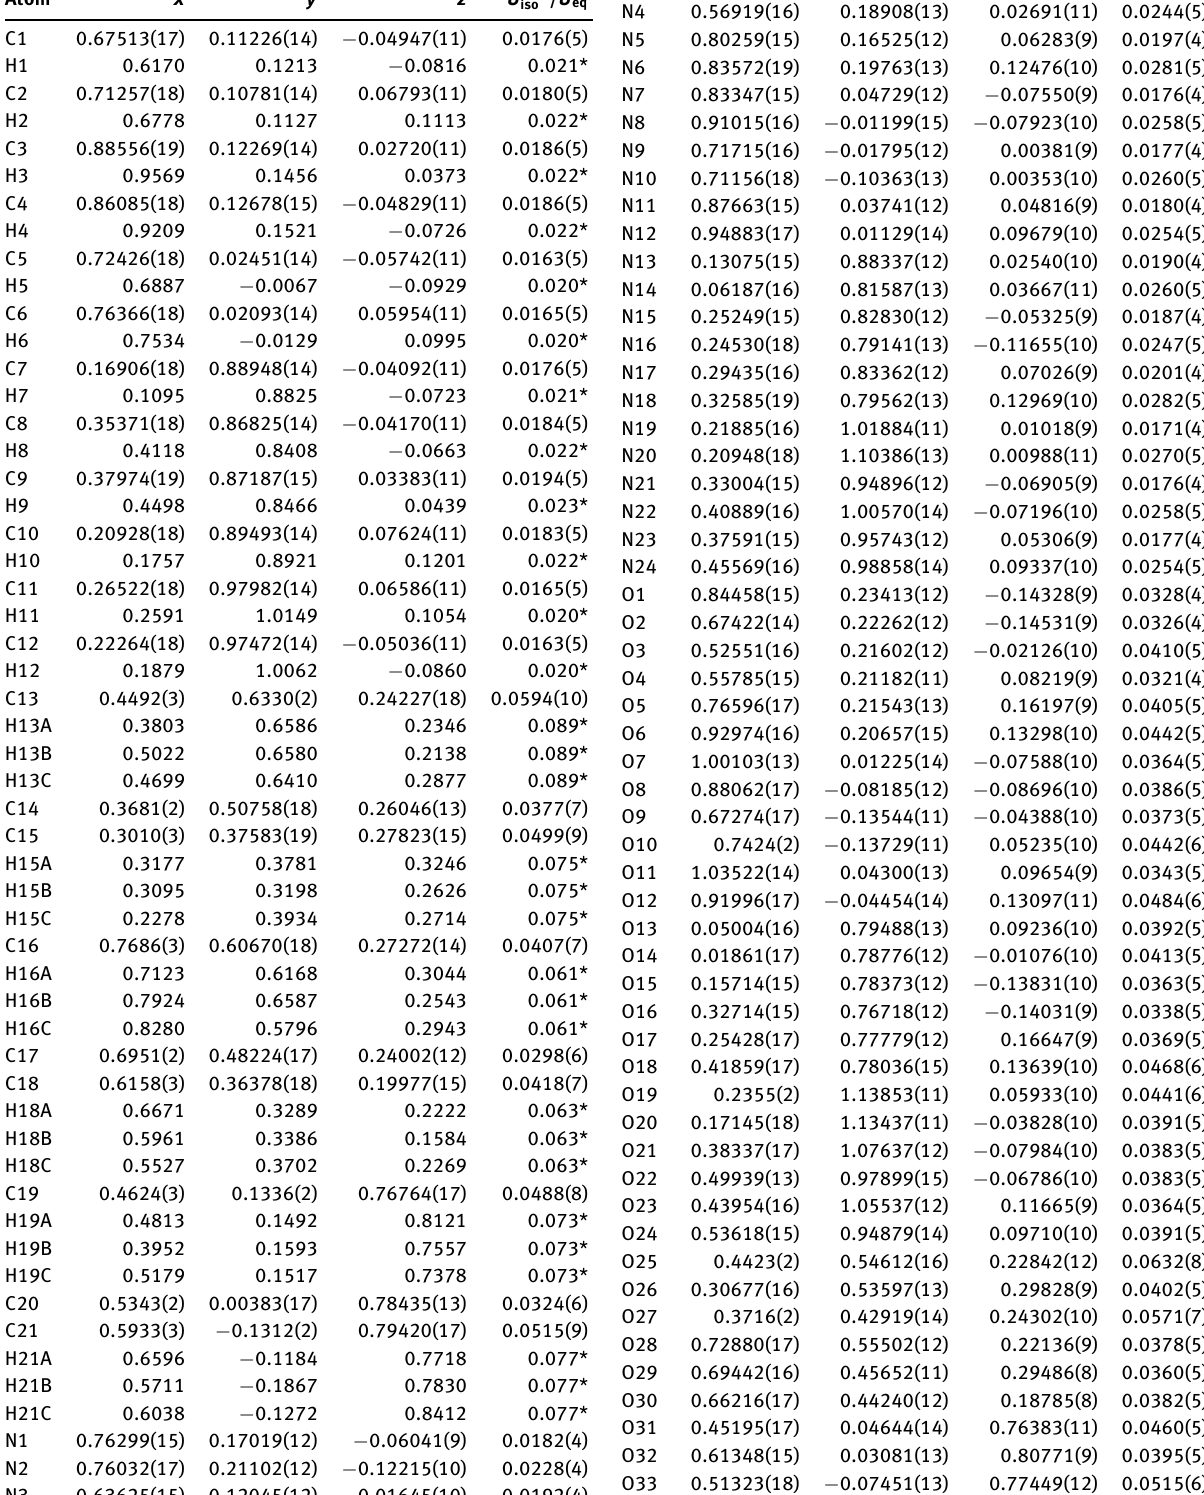
Table 2: Fractional atomic coordinates and isotropic or equivalent isotropic displacement parameters (Å 2